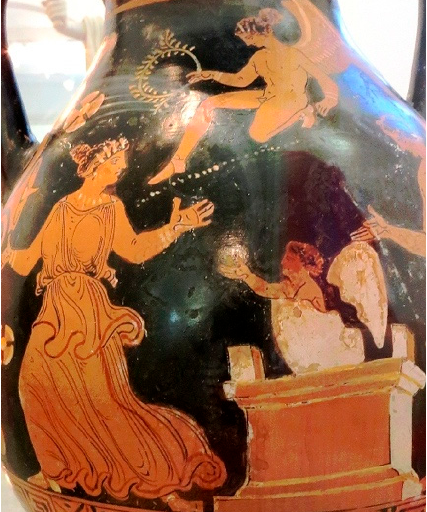
Figure 2. Apulian red-figure loutrophoros of Leda and the Swan , C4th B.C., Photographed from the Art Museum in Kiel, Germany, © H. Föll.